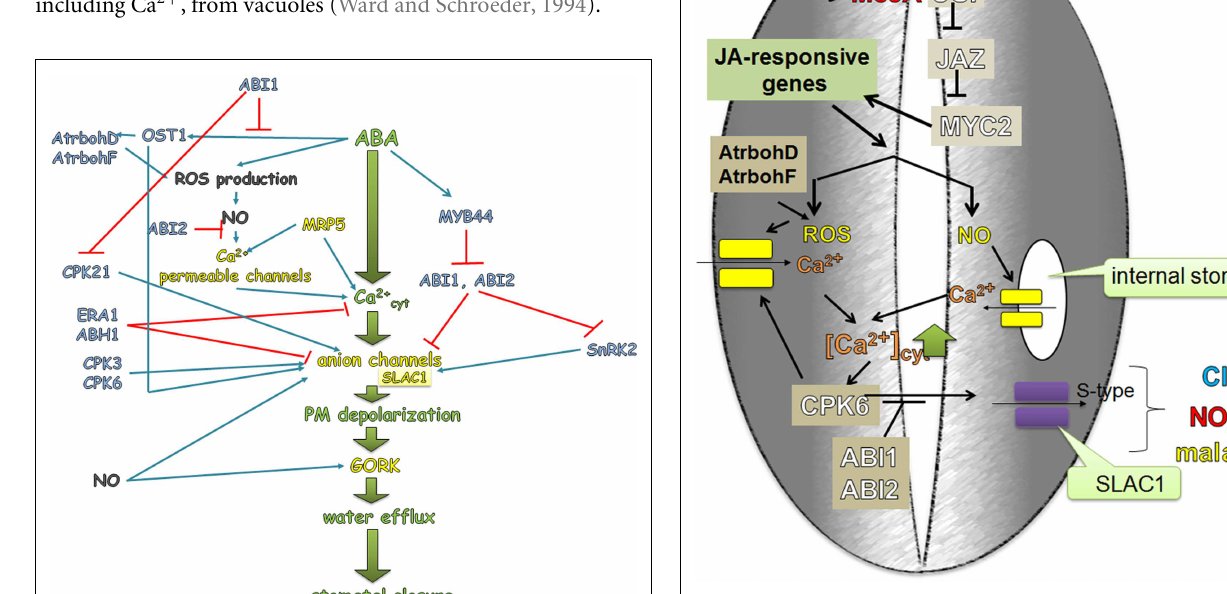
FIGURE 4 |ABA regulation of stomatal closure during drought stress . An increased level of endogenous ABA in response to drought activates a signal transduction pathway that involves a sequence of events such as the elevation of the cytosolic Ca 2 + level, which consequently activates the anion channels (S-type and R-type), which leads to membrane depolarization.The latter activate GORK, which is responsible for extruding K + from the guard cells. Simultaneous with the efflux of K + , an efflux of water is observed. Together, these events lead to a decrease in the turgor of the guard cells and to stomatal closure under drought conditions.The sequence of events, which is explained in detail in the main text and presented in green in the figure, is the core of the reactions that are induced or inhibited by different proteins that are activated by ABA. Blue arrows indicate activation, while red blunt ended lines indicate inhibition.